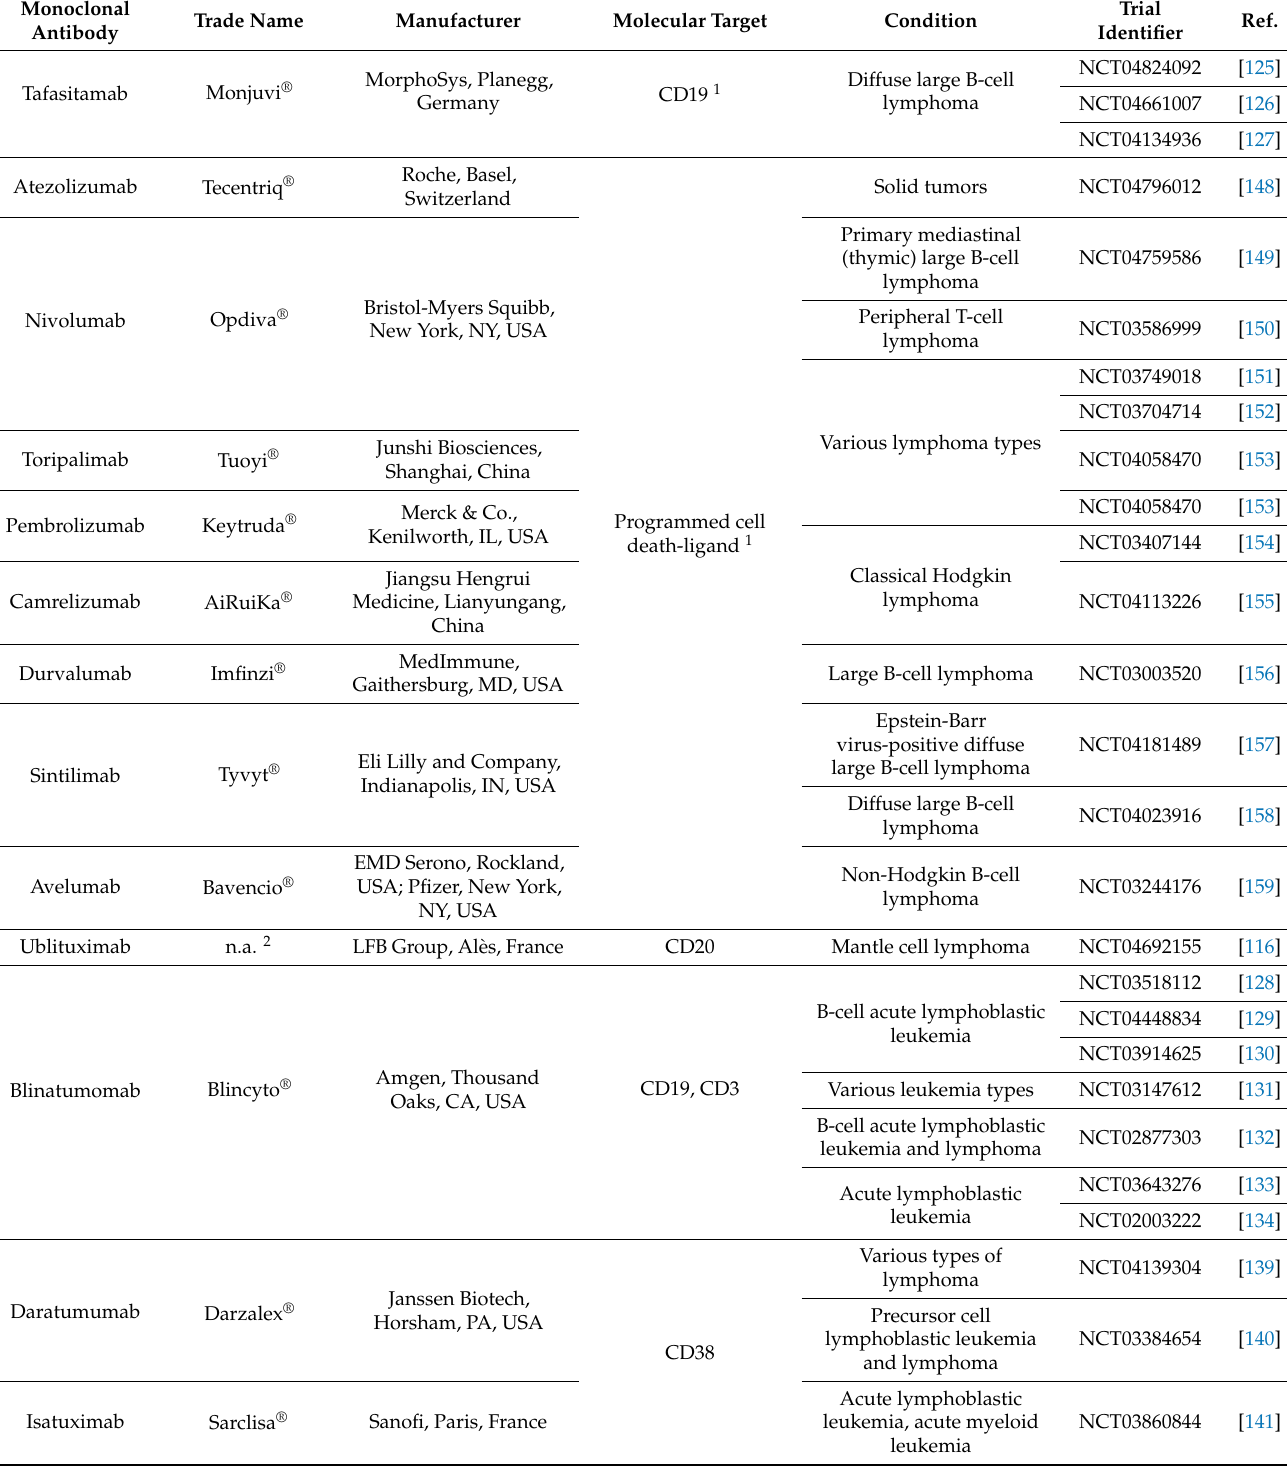
Table 3. Ongoing (not yet recruiting; recruiting; enrolling by invitation; active, not recruiting) clinical trials with mono- clonal antibodies other than rituximab in combination with vincristine on patients suffering from various types of cancer (May